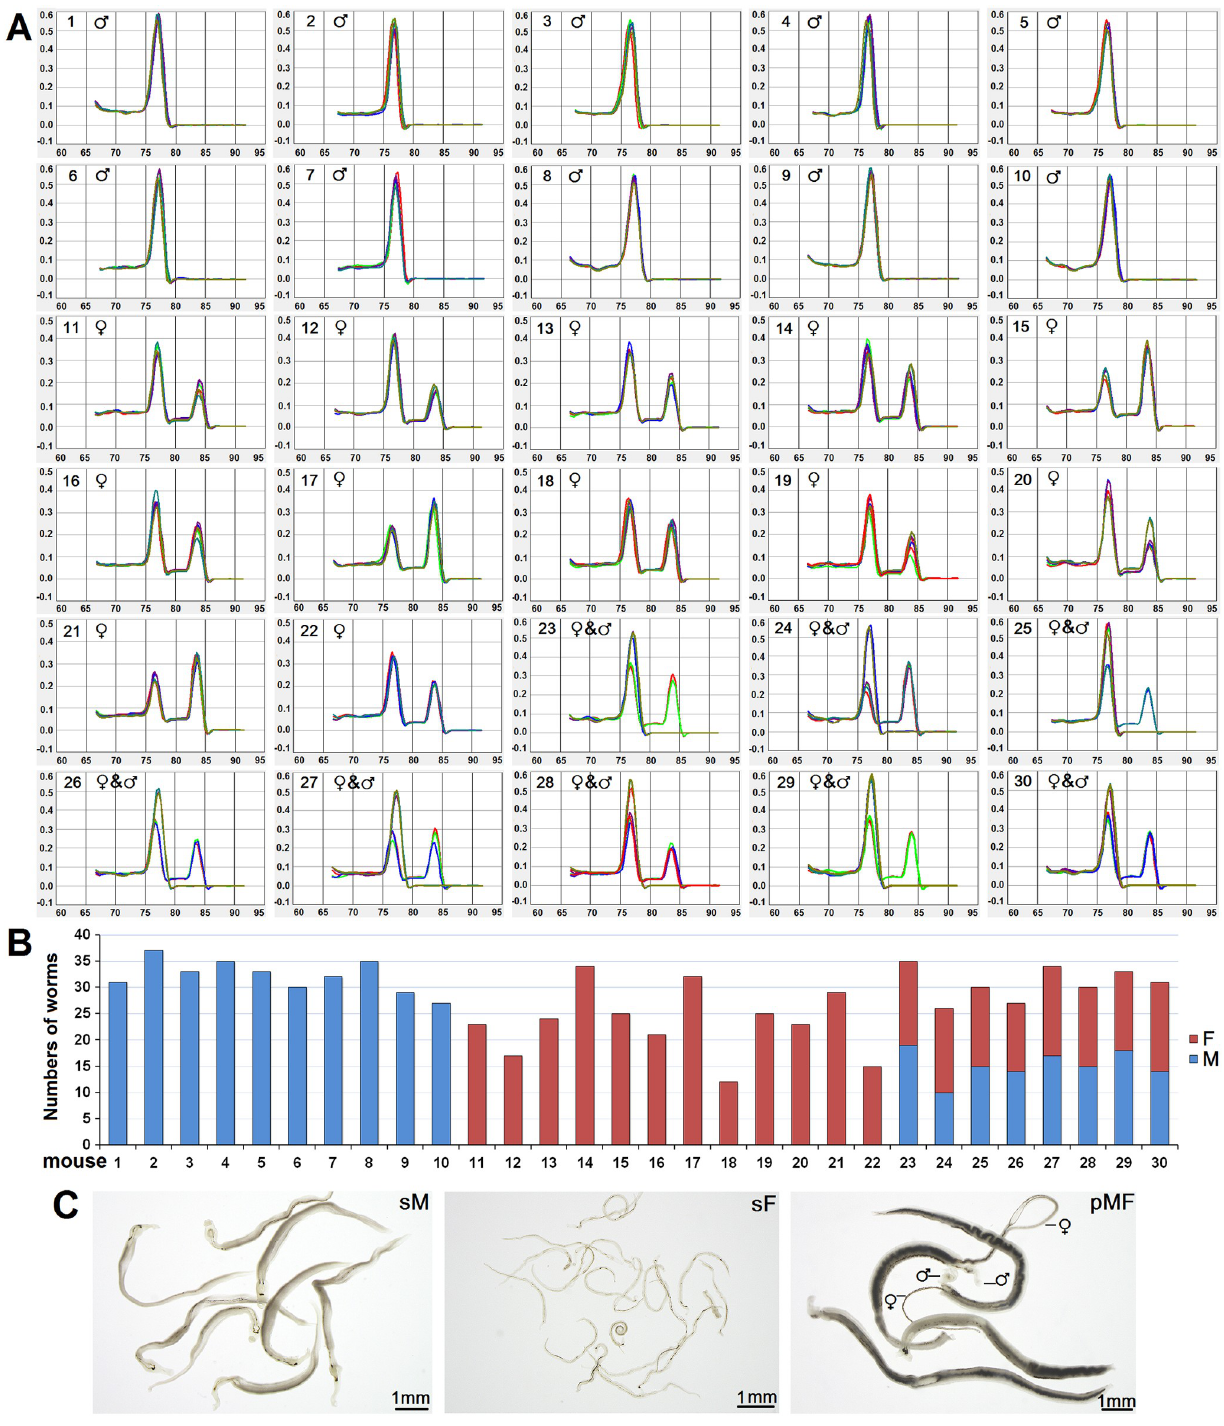
Fig 5. Single-sex and mixed-sex schistosome-infected snails are efficiently identified by duplex qPCR. (A) Duplex qPCR melting curve analysis of W chromosome-specific gene marker SjF9 and PSMD4 control for sexing cercariae released from 30 multi-schistosome infected snails. ♂ represents male cercariae, ♀ represents female cercariae, and ♀ & ♂ represents male and female cercariae. (B) Sex of cercariae released from the 30 snails was confirmed by adult worms isolated from corresponding infected mice. F represents adult females and M represents adult males. (C) Representative images of adult single-male worms (sM), adult single-female worms (sF), and adult male and female worm pairs (pFM). ♂ represents adult males, and ♀ represents adult females.